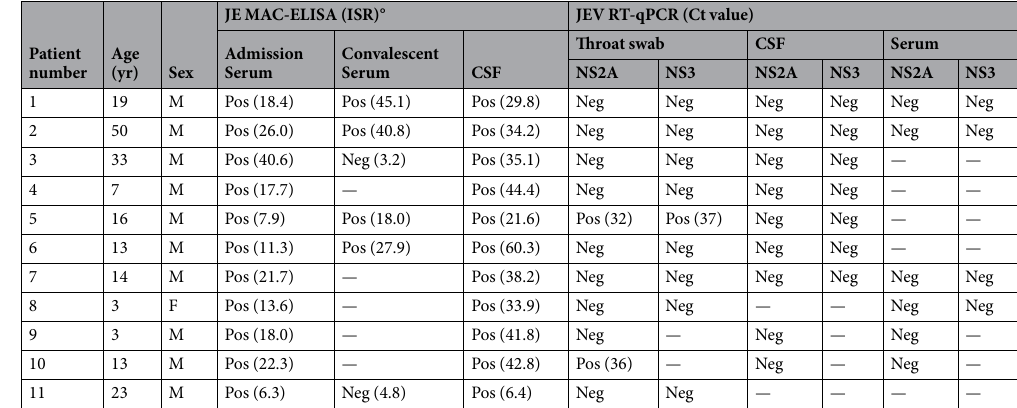
Table 1. Patients with positive results for JE MAC-ELISA or JEV RT-qPCR. M: male, F: female. CSF: cerebrospinal fluid. °Anti-JEV IgM detection using JE Detect ™ IgM Antibody Capture ELISA Kit